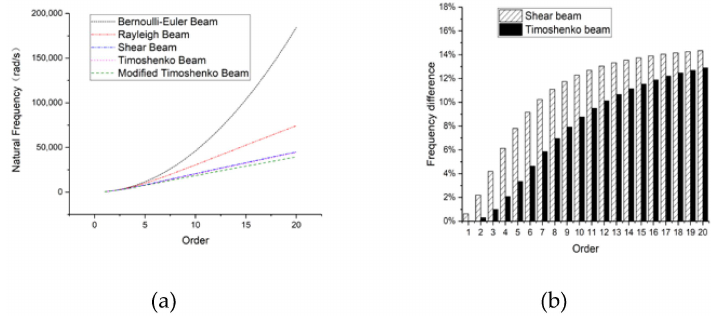
Figure 5. Natural frequencies of the 4-m-long beam: ( a ) overall frequency curve and ( b ) frequency di ff erence compared with a modified Timoshenko